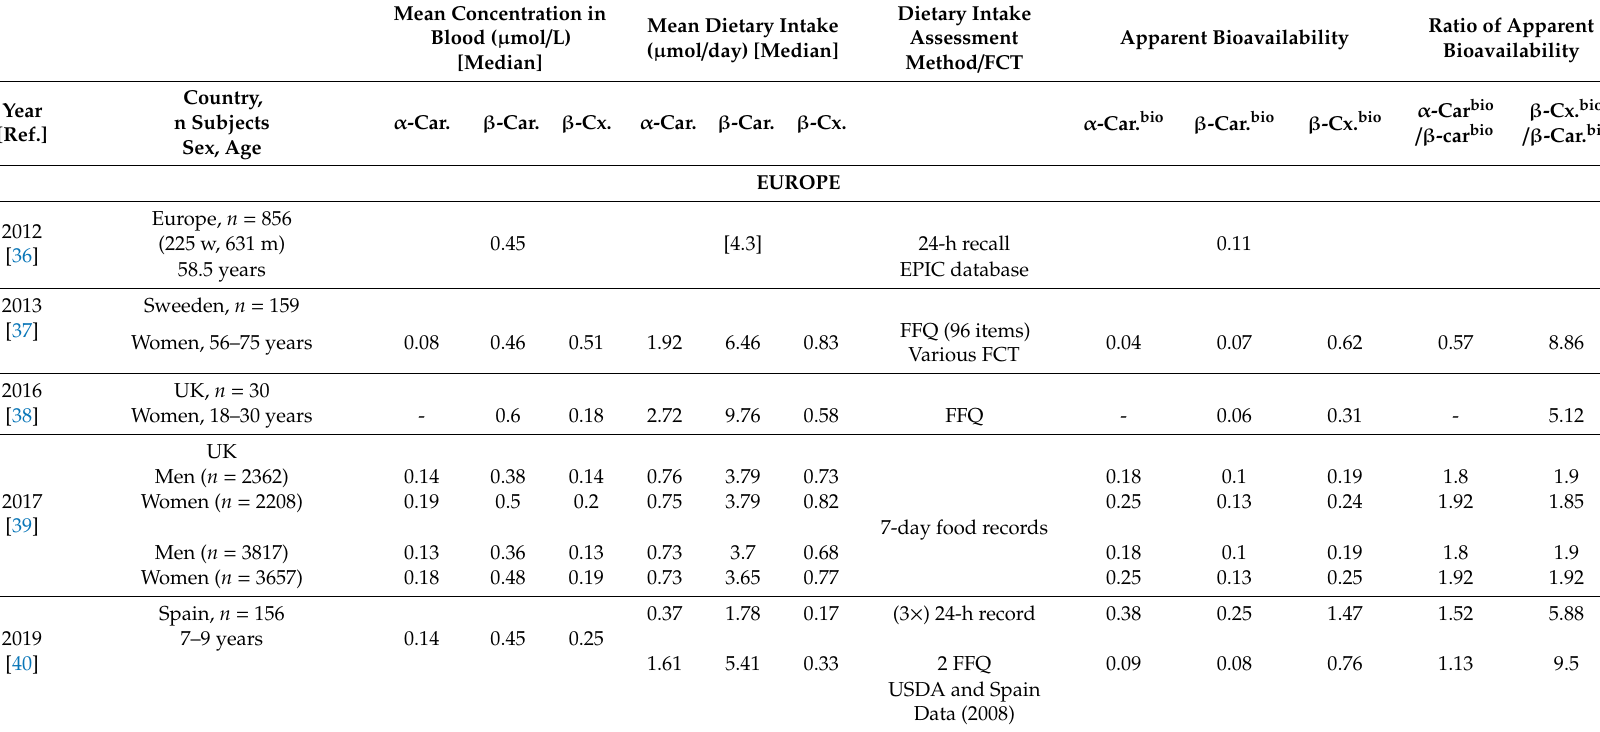
Table 2. Dietary intakes and serum or plasma concentrations (means or [medians]) of α -carotene ( α -car.), β -carotene ( β -car.) and β -cryptoxanthin ( β -cx.) from the literature